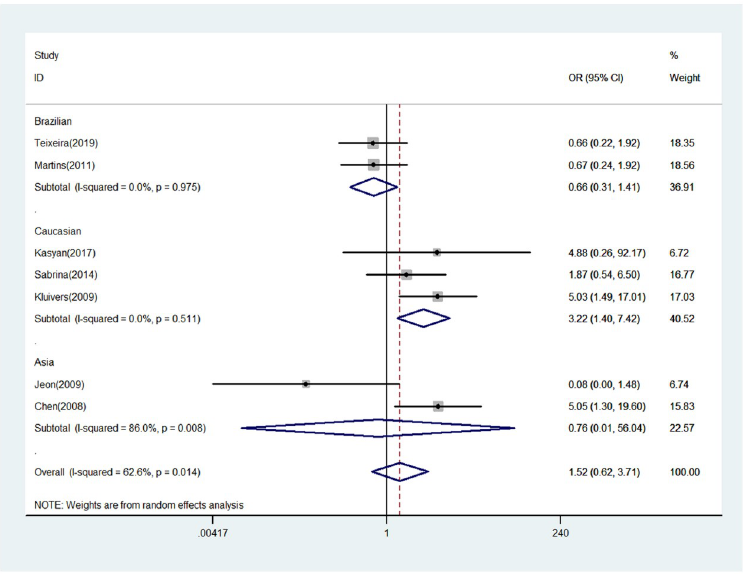
Fig 3. Forest plot of COL3A1 rs1800255 polymorphism on POP risk (recessive genetic model: AA vs. GG/GA). POP, pelvic organ prolapse; OR, odds ratio; CI, confidence